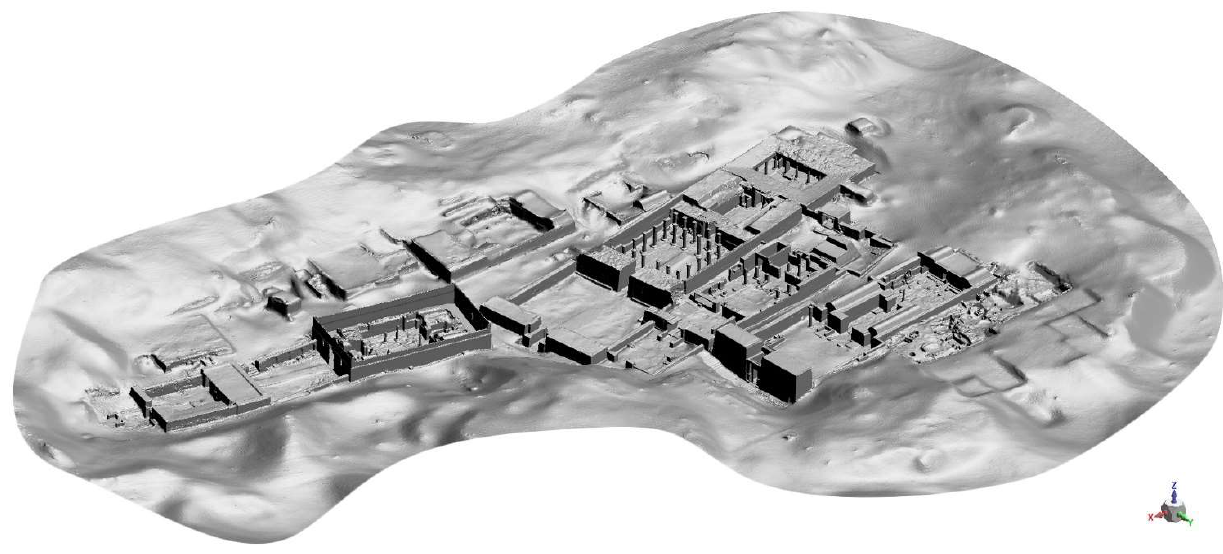
Figure 6. DSM of the whole concession of the Dutch-Italian mission to